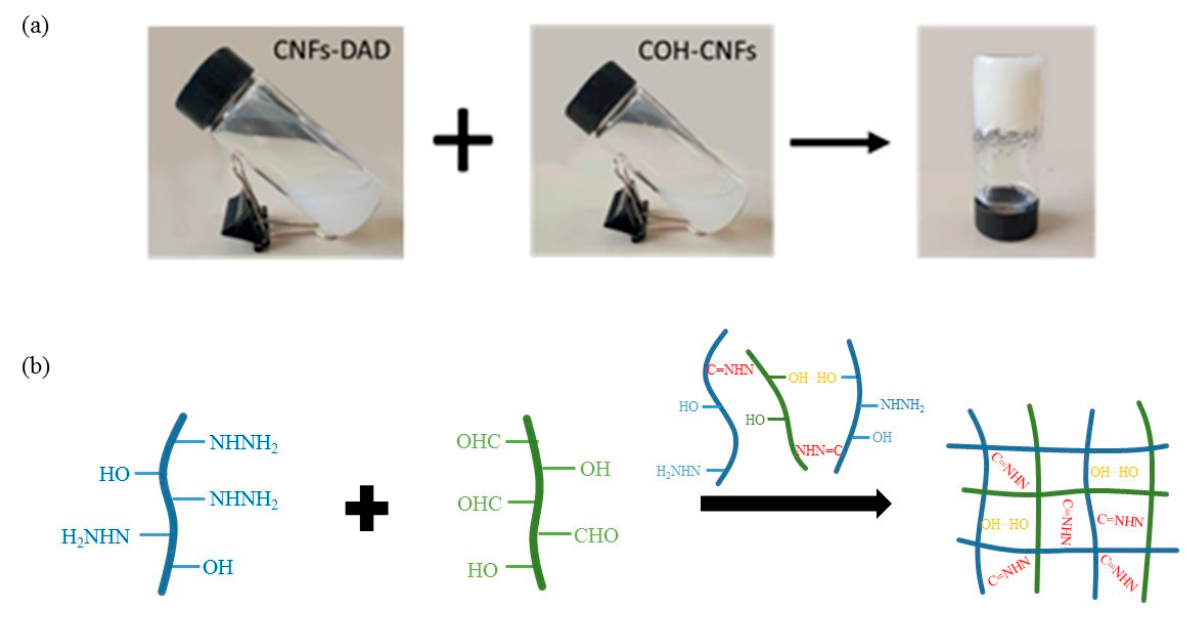
Figure 2. Schematic representation of chemically cross-linked CNF hydrogel and the reactions in the crosslinking process: ( a ) Photos of the gelation, ( b ) Schematic diagram of chemical reactions between chains in the cross-linking process.